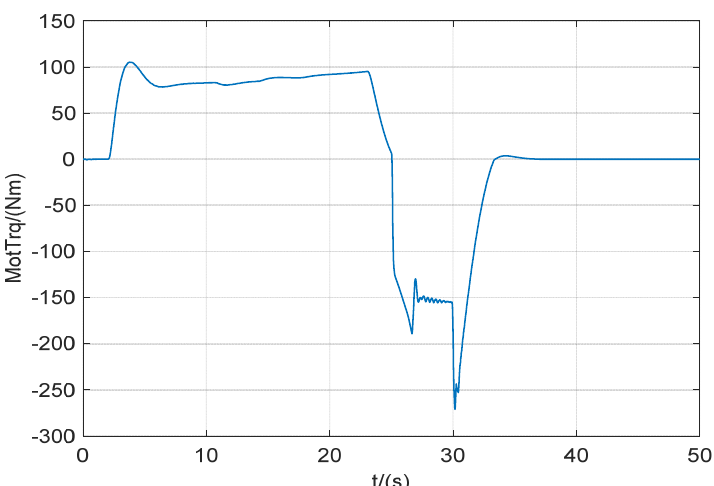
Figure 14. The motor braking torque curve.